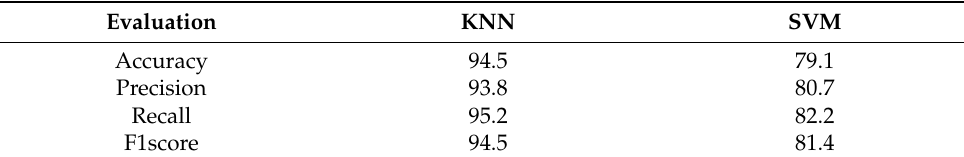
Table 2. Results of accuracy, precision, recall, and F1score after using FGA.